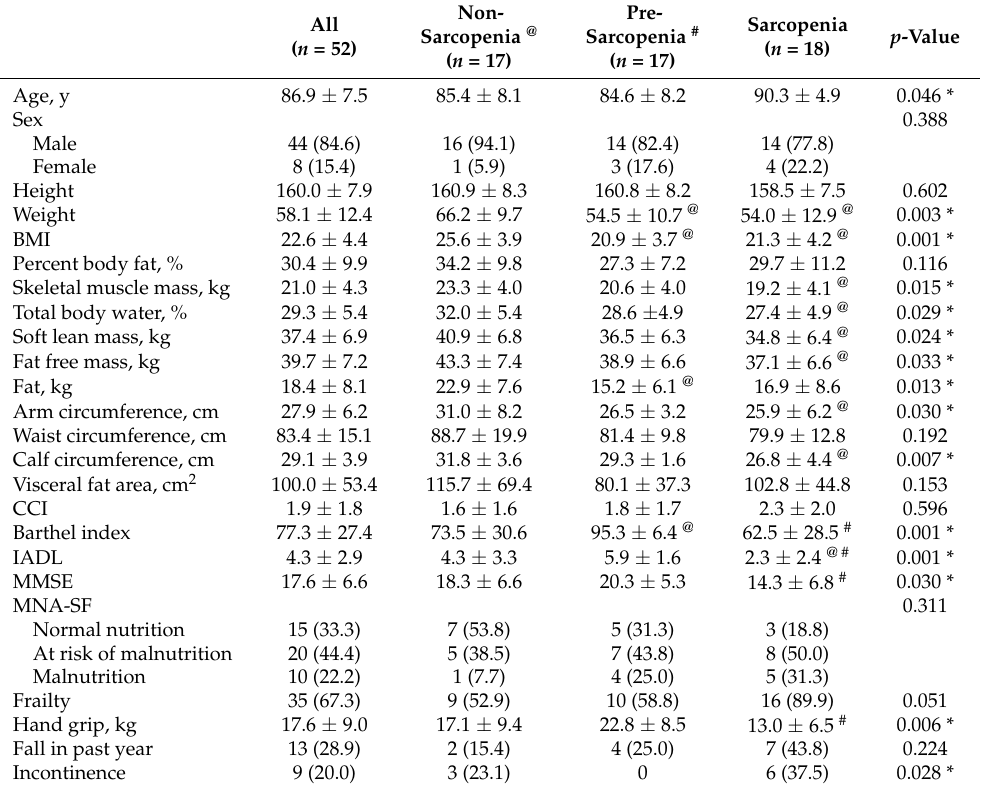
Table 1. Baseline demographic characteristics, variables of clinical assessment, and comprehensive geriatric assessment of older patients between